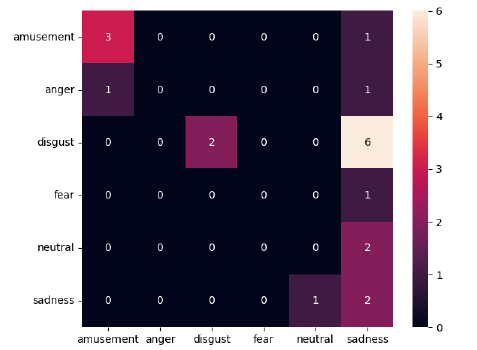
Figure 5: Confusion matrix for the first results produced by the model using the full